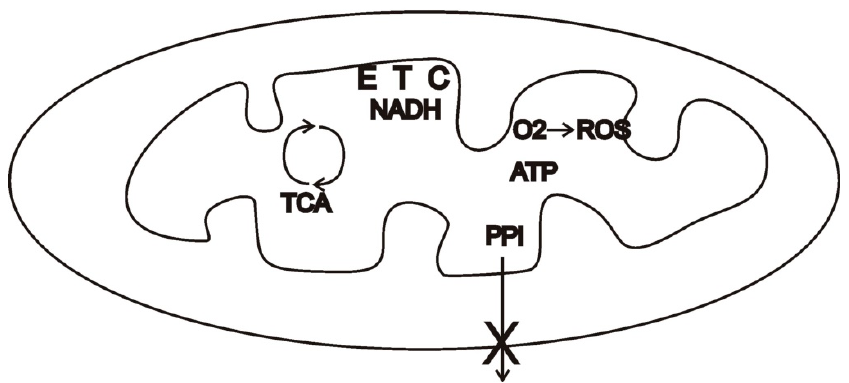
Figure 2. Simplified schemata of a protomitochondrion in metabolic state 4 [21]. The protomitochondrion exhibits a loss-of-function mutation and cannot export pyrophosphate (PP i ). Under favorable conditions, the protomitochondria continues to oxidize substrate in the Krebs or TCA cycle until all of the ADP is converted to ATP. The electron transport chain (ETC) continues to oxidize NADH until the proton gradient is maximal and the electron carriers of are highly reduced. High levels of reactive oxygen species (ROS) result. In this way, hoarding the products of chemiosmosis may be detrimental to a protomitochondrion, while sharing with a proto-host (Figure 1) may be beneficial.